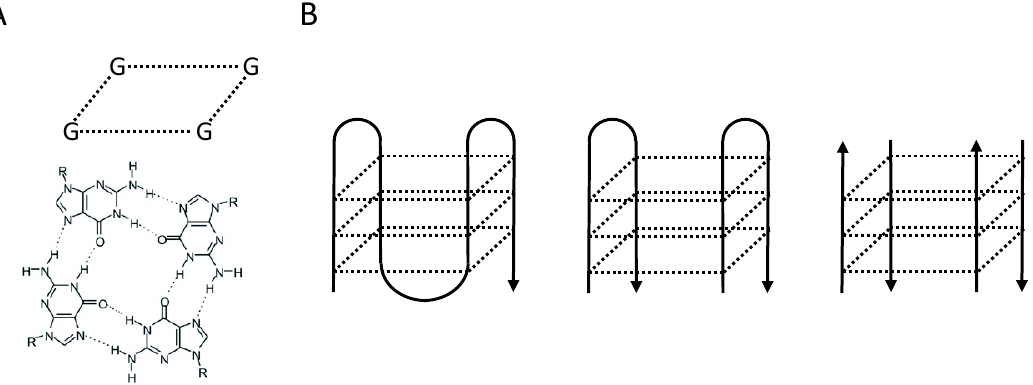
Figure 1. G-quadruplex structures form at G-rich DNA motifs. ( A ) Representation of a G-quartet Figure 1. G ‐ quadruplex structures form at G ‐ rich DNA motifs. (A) Representation of a G ‐ quartet formed by four guanines residues and stabilized by Hoogsteen base pairing. ( B ) Multiple G-quartets formed by four guanines residues and stabilized by Hoogsteen base pairing. (B) Multiple G ‐ quartets stack into G-quadruplexes. G-quadruplex can form on a single DNA strand (left), or between two stack into G ‐ quadruplexes. G ‐ quadruplex can form on a single DNA strand (left), or between two (middle) or four (right) DNA (middle) or four (right) DNA strands.